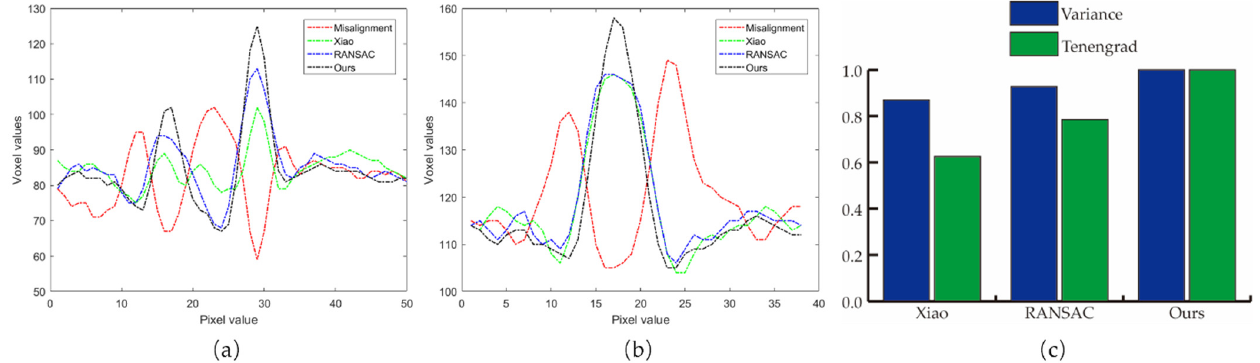
Figure 11. Graphs showing the numerical analysis results for image quality reconstruction. ( a ) The pixel value of the green line (I) position inside the red box in Figure 10. ( b )The pixel value of the green line (II) position inside the red box in Figure 10. ( c ) Normalized evaluation results for Variance and Tenengrad .